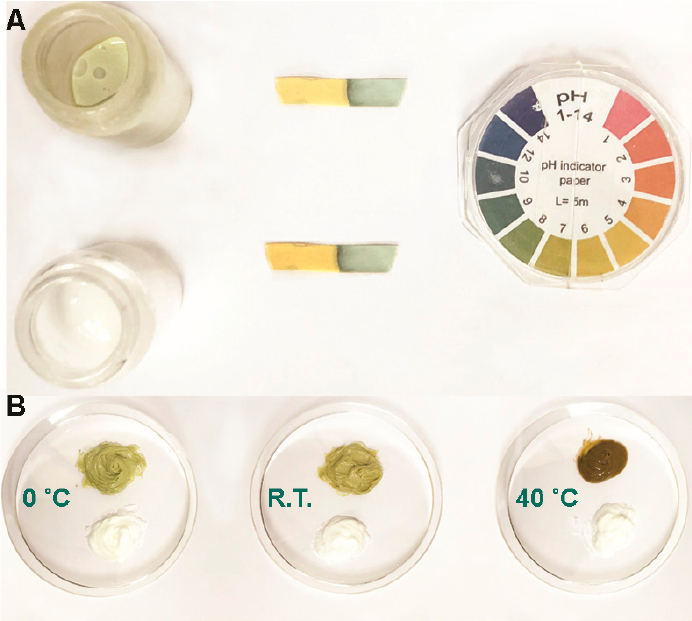
Figure 1. ( A ) Stability test for the herbal and base creams at di ff erent temperatures. ( B ) pH determination for the herbal and base creams diluted in double-distilled